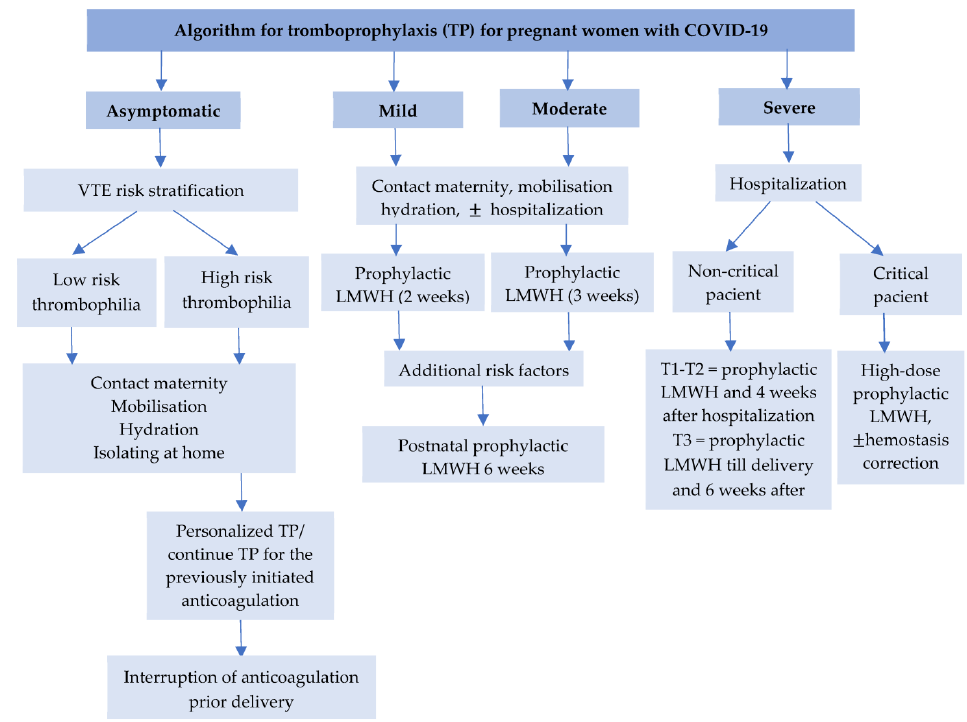
Figure 3. Algorithm for thromboprophylaxis for pregnant women with COVID-19. (T1, T2, T3 — first, second, and third trimester, VTE — venous thrombembolism, LMWH — low molecular weight